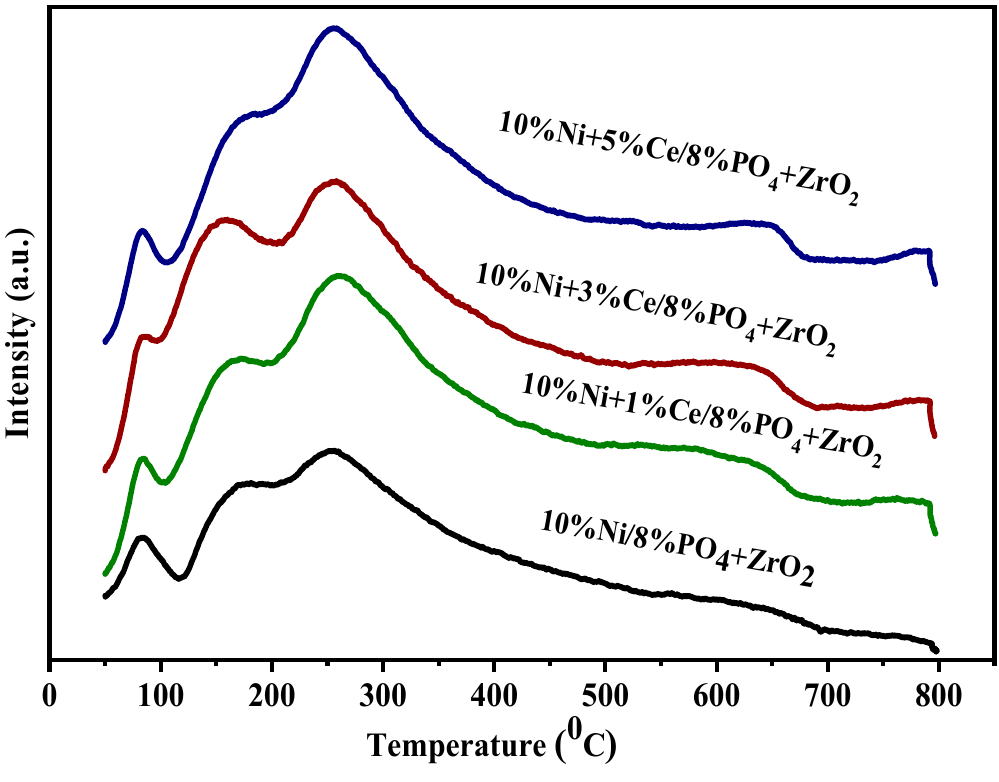
Table 3. Distribution of basic sites for Ni-supported catalysts.